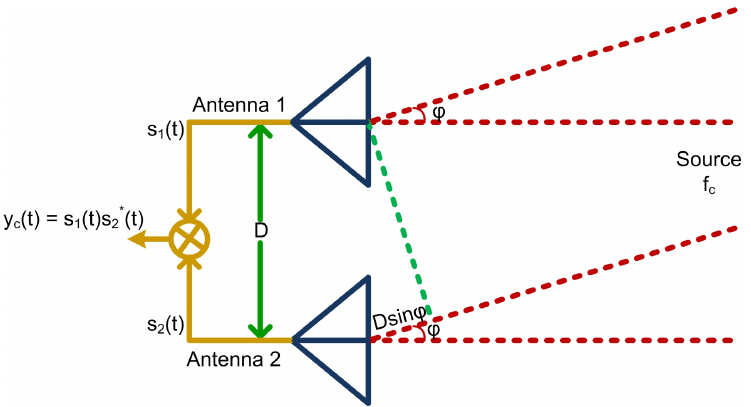
Figure 2. The interferometric radar